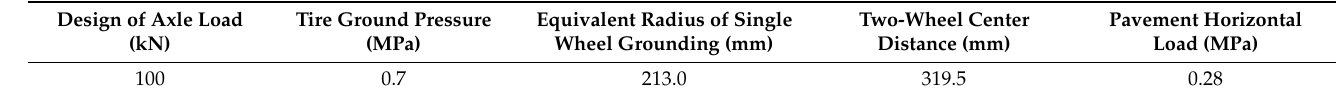
Table 9. Design axle load parameters.